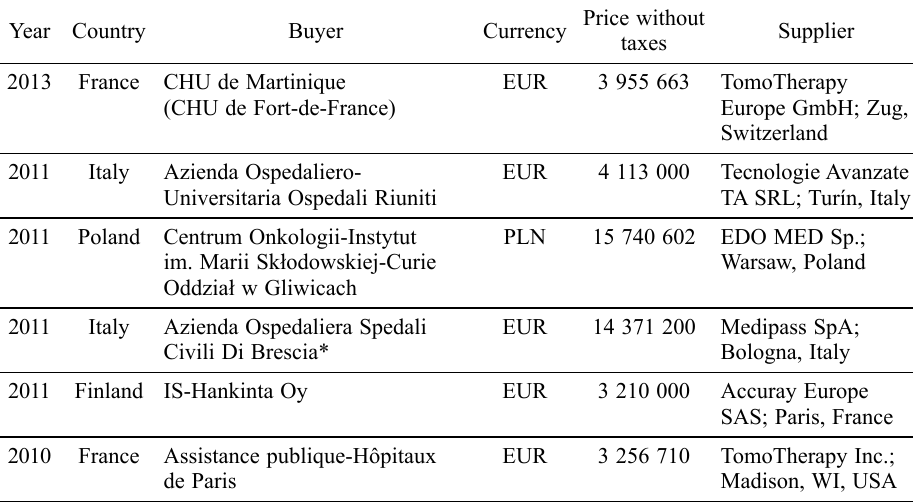
Table 1. Price information for tomotherapy units obtained from public-procurement databases Year